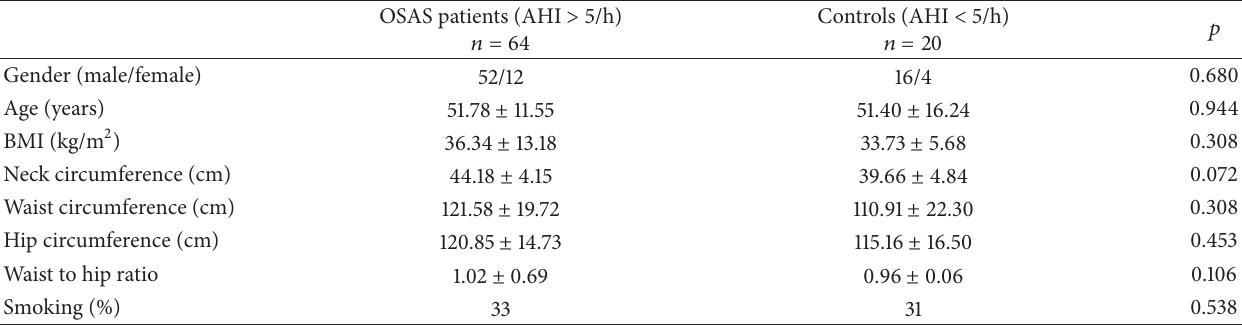
Table 1: Comparison of anthropometric characteristics between OSAS patients and controls.